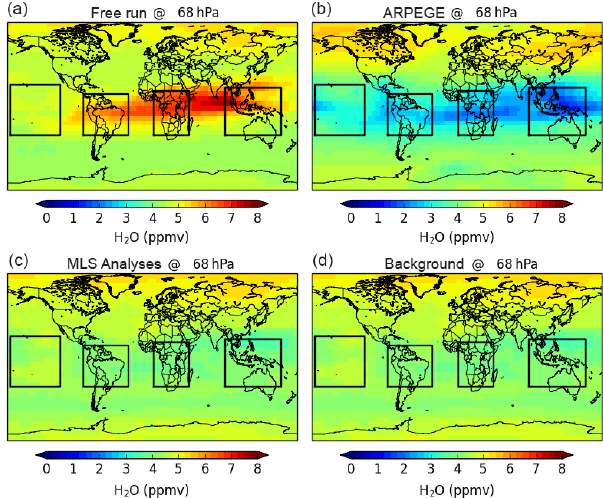
Figure 12. Monthly averaged H 2 O fields at 68hPa in January 2012 in the model space (in the model grid and time samplings) from the free run (MOCAGE, a ), ARPEGE (b) , MLS analyses (assimila- tion, c ) and the background (d)